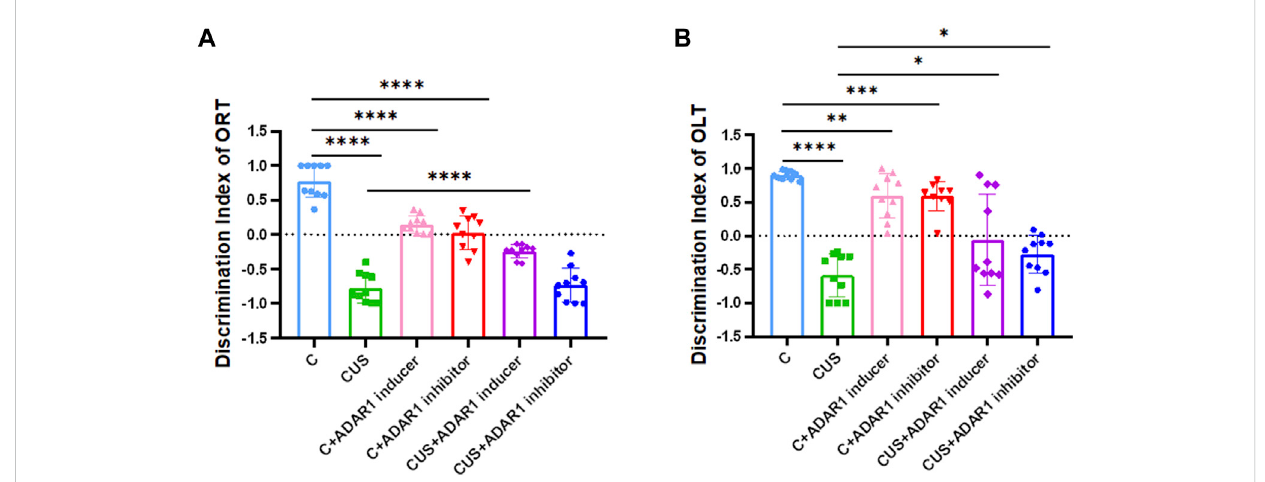
FIGURE 2 ADARl inducer alleviates spatial and non-spatial cognitive impairment in mice exposed to chronic unpredictable stressors. (A) Discrimination index of the mice in the new object recognition test (ORT). (B) Discrimination index of the mice in the new object location test (OLT); “ C ” represents normal control group, “ CUS ” represents chronic unpredictable stressors-treated model group, “ C + ADARl inhibitor ” represents ADARl inhibitor (PEN) intervention control group, “ C + ADARl inducer ” indicates ADARl inducer (INF- γ ) intervention control group, “ CUS + ADAR1 inducer ” represents ADARI inducer intervention model group, and “ CUS + ADARl inhibitor ” indicates ADARl inhibitor intervention model group. * p < 0.05, ** p < 0.01, *** p < 0.001, **** p < 0.0001, (n = 10/group). The data are expressed as mean ± standard